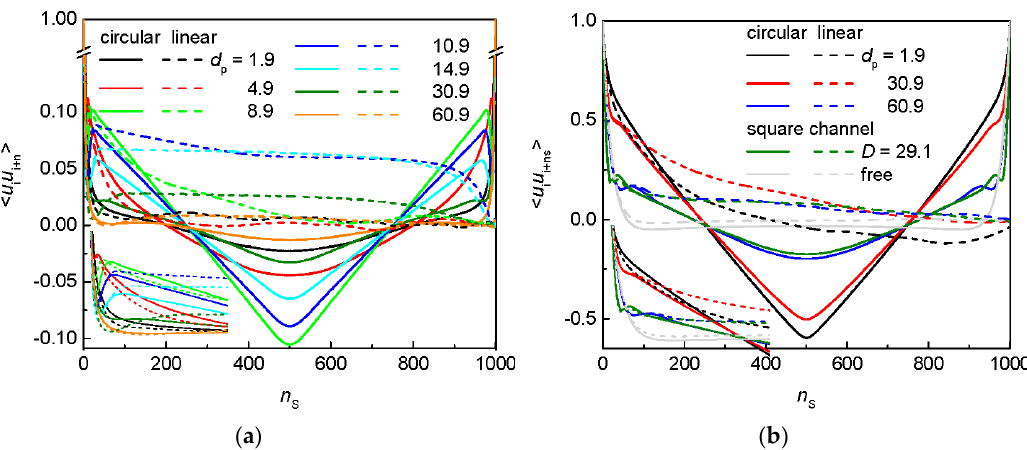
Figure 10. Orientation correlations for: a flexible chain ( a ); and a semiflexible chain ( b ) of circular and linear topology in an array of nanoposts of fixed passage width w p = 2 and various post diameters d p . The insets zoom in the initial decay of the orientation correlations.